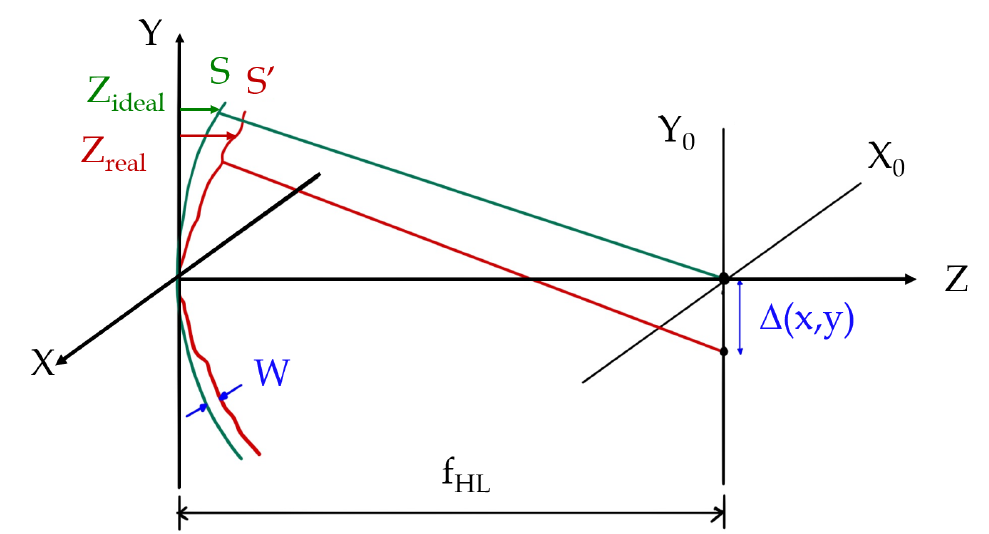
Figure 4. Geometry for the relation between the ideal sagittal, the real sagittal and the wave aberration function ( W ). The wave aberration ( W ) is also related to the ray aberration ( ∆ ( x , y )